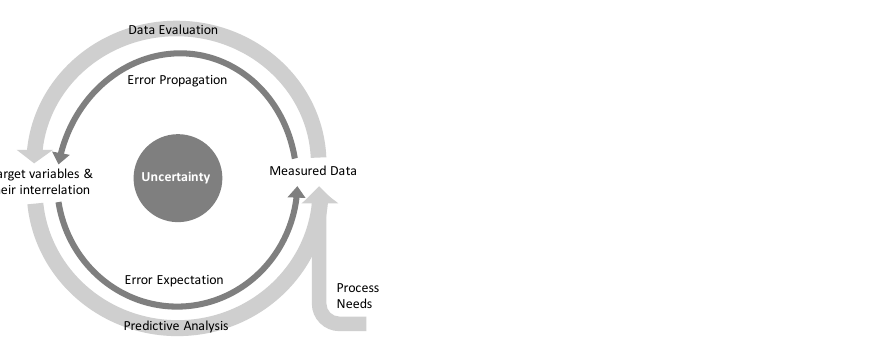
Figure 8. Data evaluation and predictive analysis including uncertainty and propagating it along these